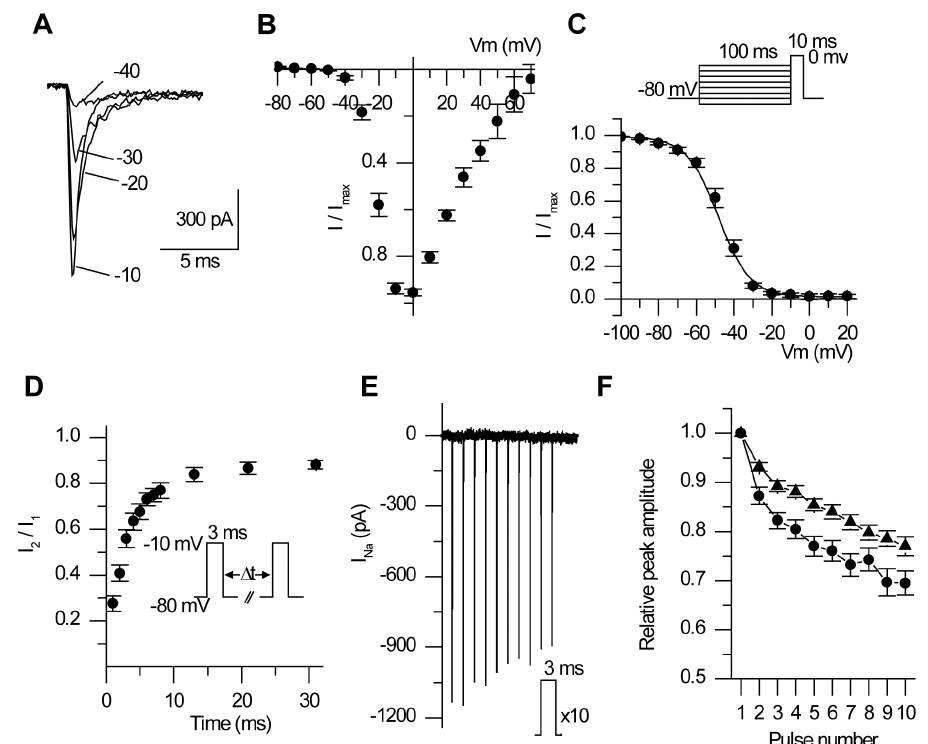
Figure 1. Properties of the voltage-gated sodium current from honeybee ALNs. A, Sodium current traces obtained from an ALN for voltage steps to the indicated potential from a holding potential of 2 80 mV. B, Mean relative I/V curve (n=24). C, Mean steady-state inactivation curve (n=12). D, Recovery from fast inactivation in ALN (n=12). E, Use-dependent decrease in the amplitude of the sodium current observed in an ALNs submitted to a 10-pulses train at 13 Hz. I, Average decrease in the amplitude of the sodium current in ALNs submitted to a 10-pulse train at 13 Hz (filled triangles, n=36) or 35 Hz (filled circles n=7).